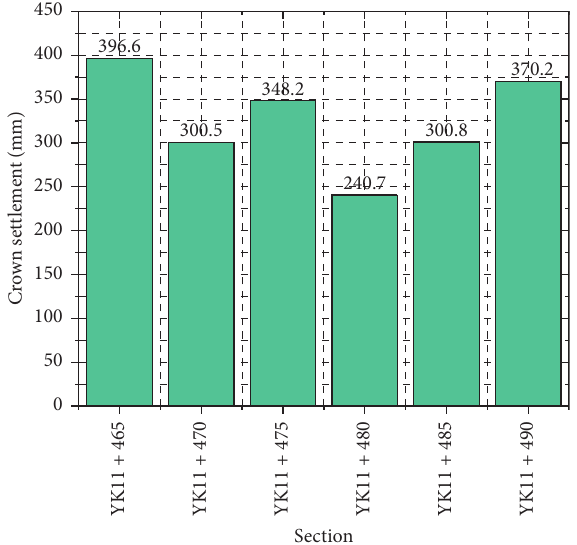
Figure 3: Comparison of the vault settlement of 6 sections (each section is 5meters